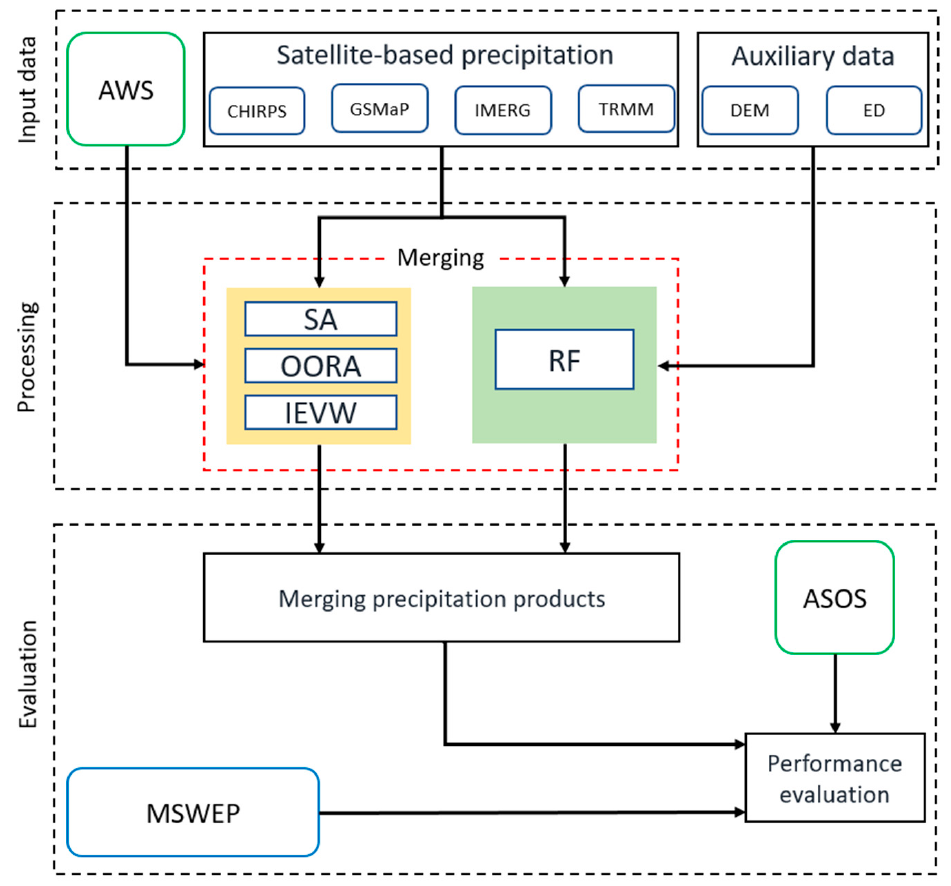
Figure 2. The overall workflow in this study. In the final step, several continuous indices (e.g., MAE, RMSE, and KGE) and cate- gorical indicators, including the probability of detection (POD), false alarm rate (FAR), and critical success index (CSI), chose to evaluate the accuracy and reliability of